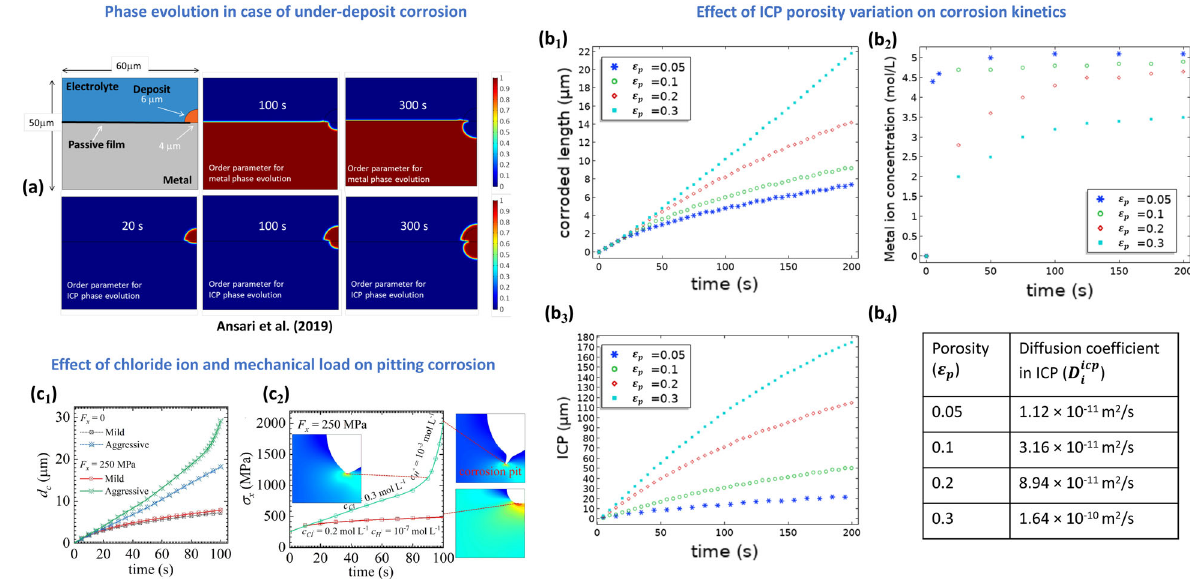
Fig. 3 Effect of porosity and mechanical stresses of ICP on pitting corrosion. a Under-deposit corrosion 80 . b 1 – b 4 The effect of a change in porosity of the ICP phase on the corroded length, metal ion concentration, ICP evolution, and ICP diffusion coef fi cient 80 . c 1 – c 4 Variations in corrosion depth and corresponding von Mises stress as functions of time, loading and electrolyte concentration 82 . a and b 1 – b 4 are reproduced with permission from ref. 80 , published by nature springer in 2019. c 1 – c 4 are reproduced with permission from ref. 82 , published by Elsevier in